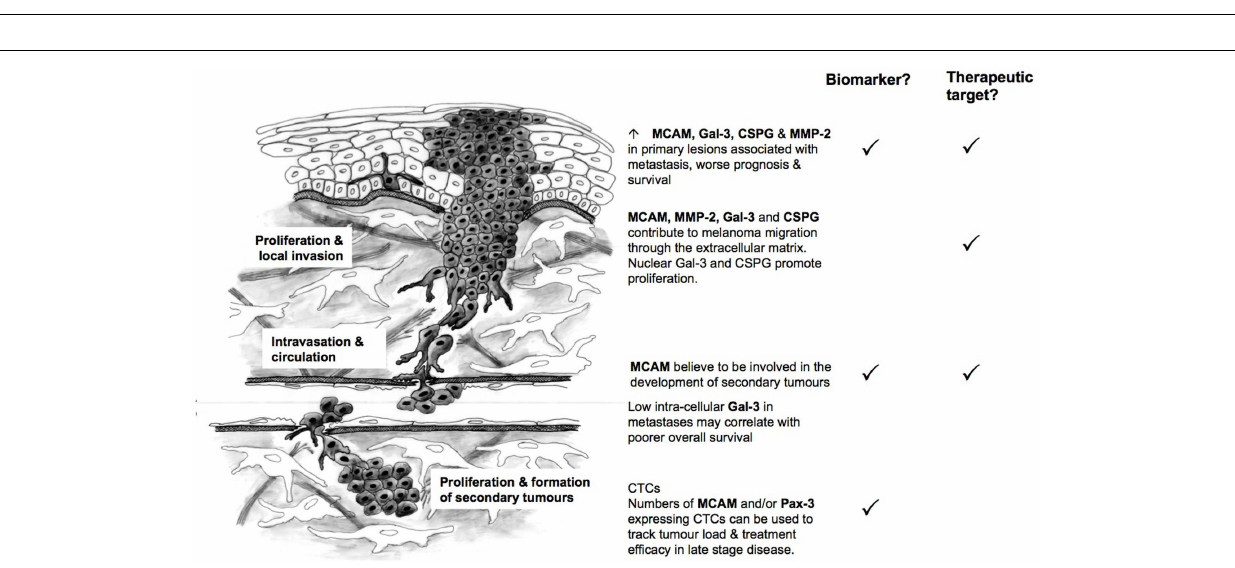
FIGURE 1 | Functional associations between MCAM, Gal-3, CSPG4, MMP-2, and PAX-3 .